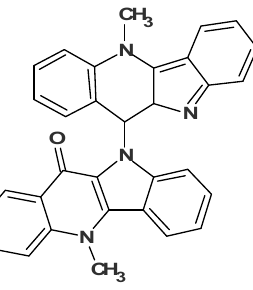
Figure 8. Structure of the degradant 2.